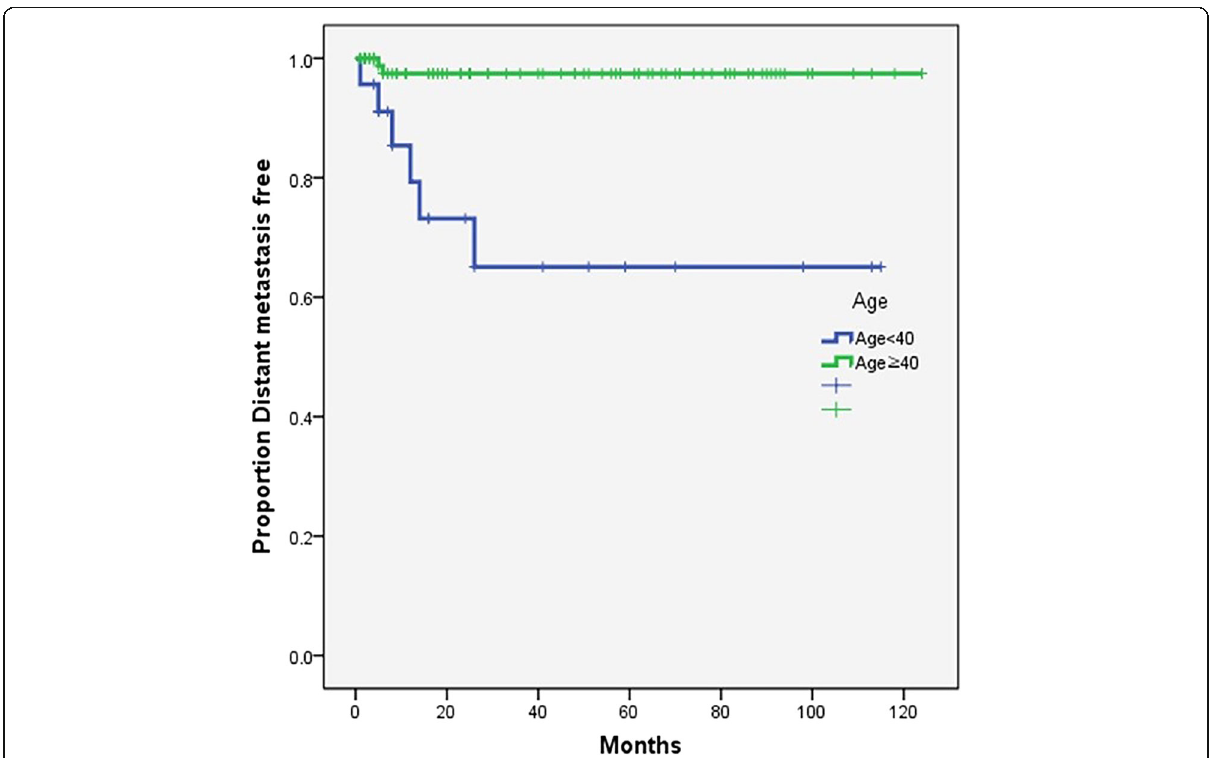
Fig. 1 Kaplan-Meier overall survival curve (log-rank p =